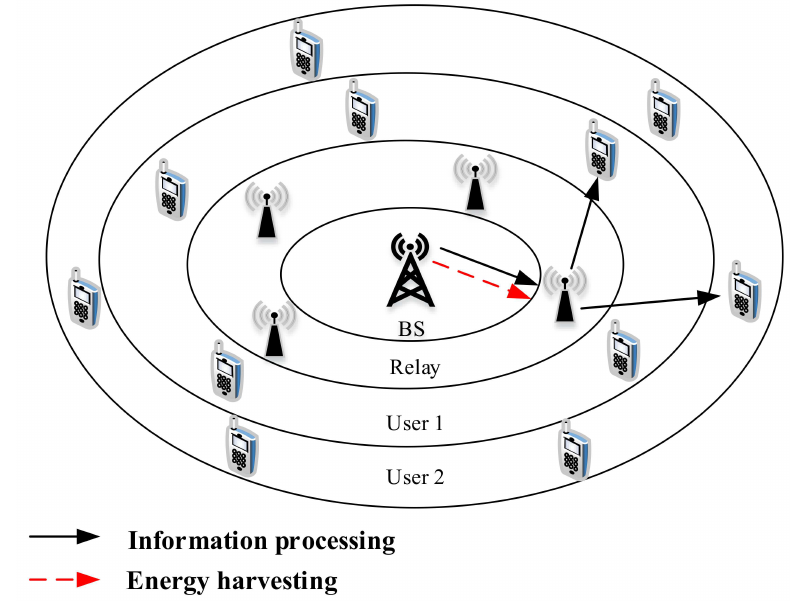
Figure 1. System model of downlink in the Non-linear Energy Harvesting (NEH)-NOMA